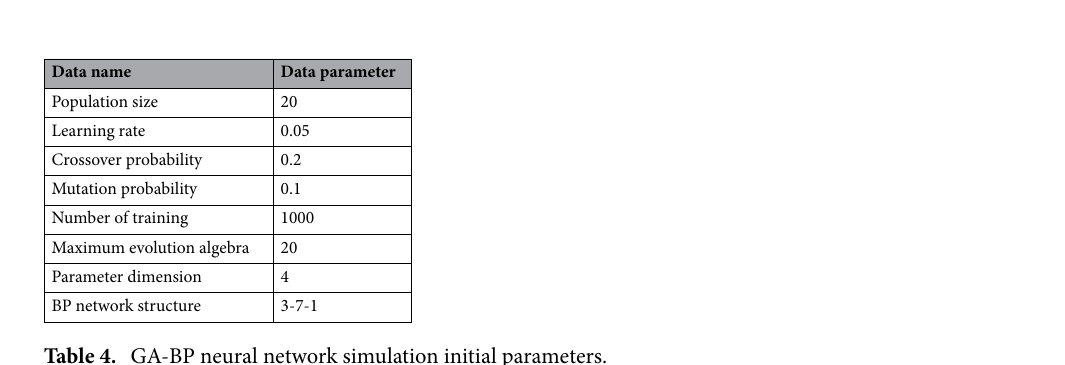
Table 4. GA-BP neural network simulation initial